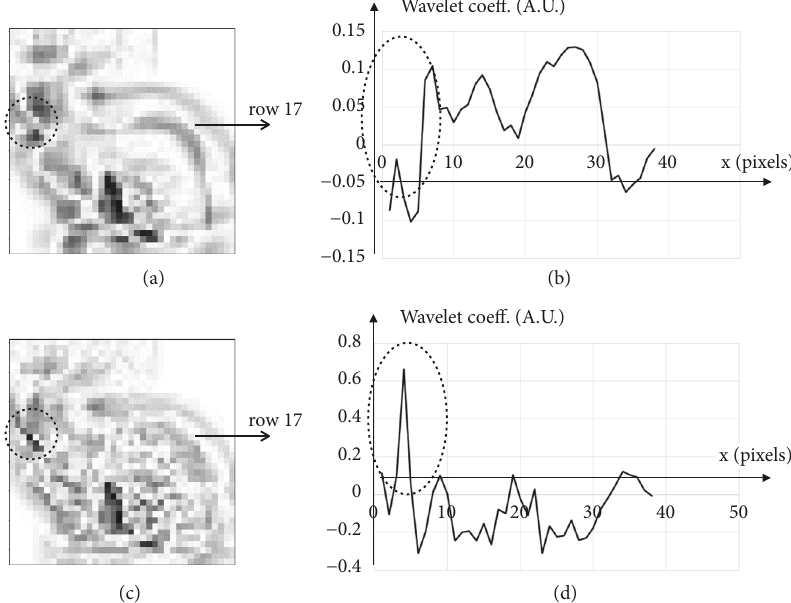
Figure 12: Wavelet coefficients in 5 th plane for source and normalized images, row 17 on the right. The layout is the same as in Figure